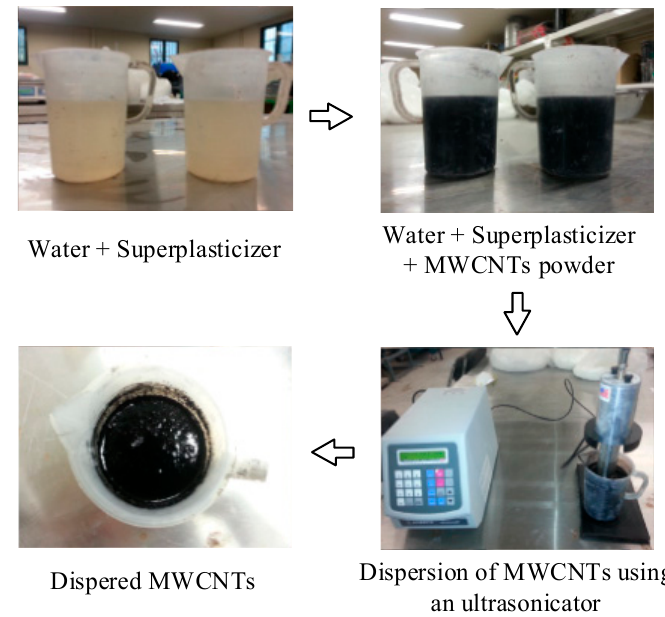
Figure 3. Schematic of MWCNTs dispersion.